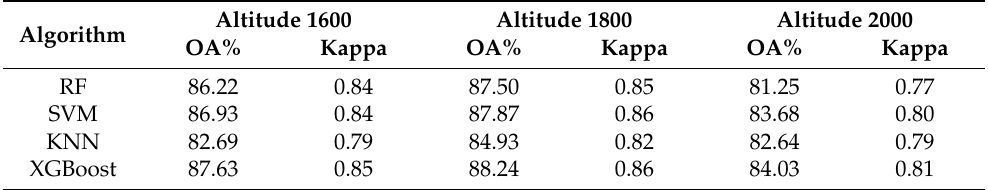
Table 9. Classification results of optimal characteristics of tree species at different altitudes.